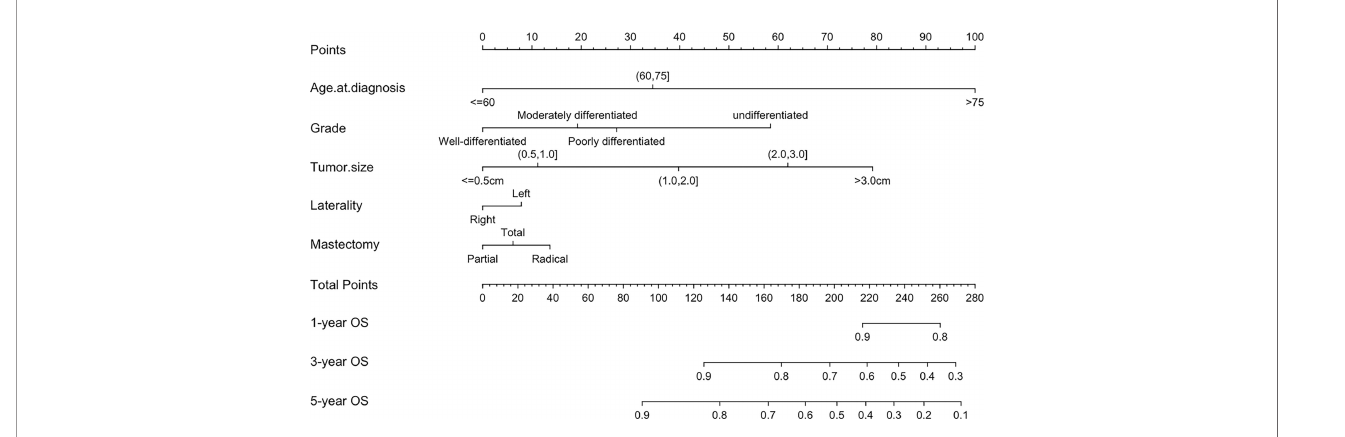
FIGURE 3 | Nomogram for predicting OS in patients with pT1-2N0M0